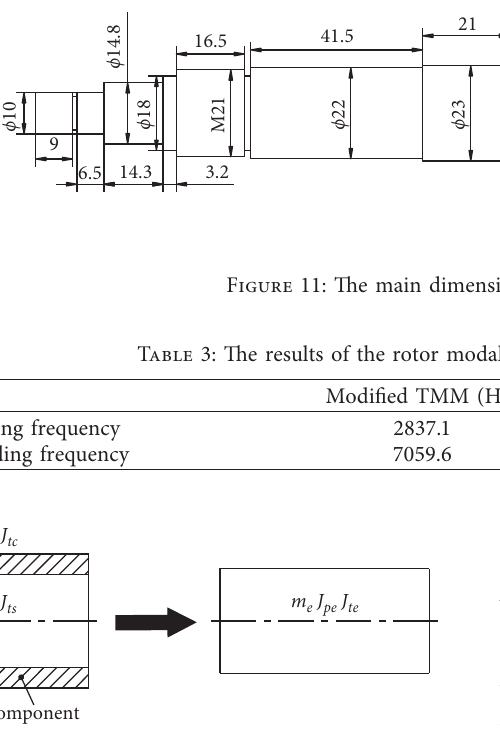
Figure 12: The rotor assembly segment and equivalent